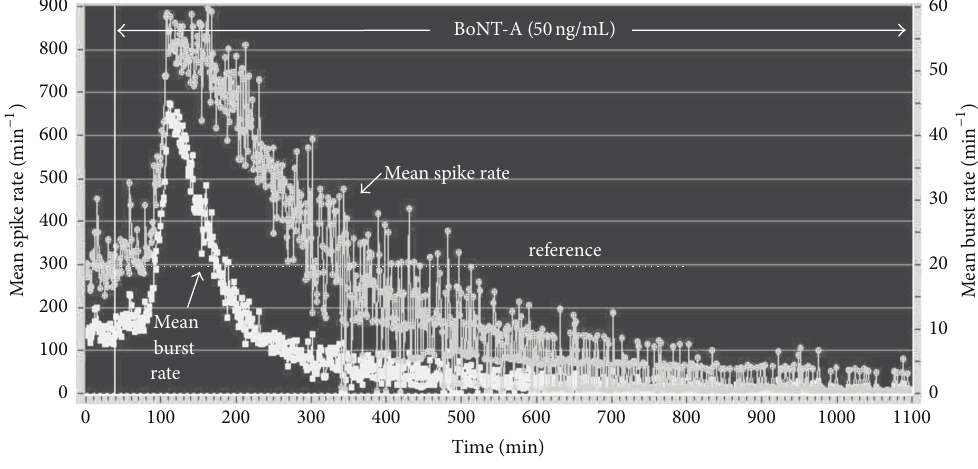
Figure 6: Average spike (S) and burst (B) rate plot per minute of SC network activity exposed to 50 ng/mL BoNT-A at 138 minutes into the experiment (age: 30 d.i.v.; 34 discriminated units). A sharp increase in spike counts and bursts occurs after a delay of 62